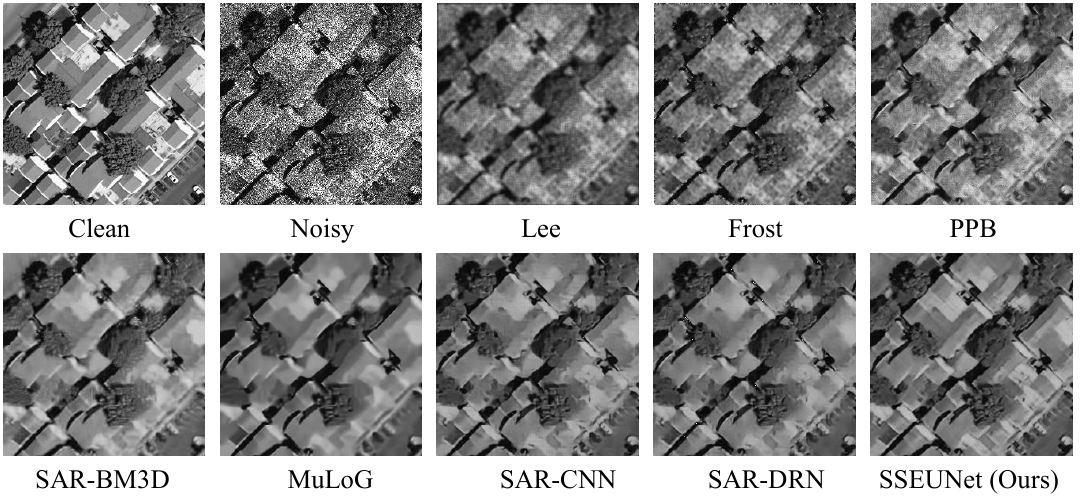
Figure 8. Visual results of simulated images. Table 3. ENL results on real-world SAR